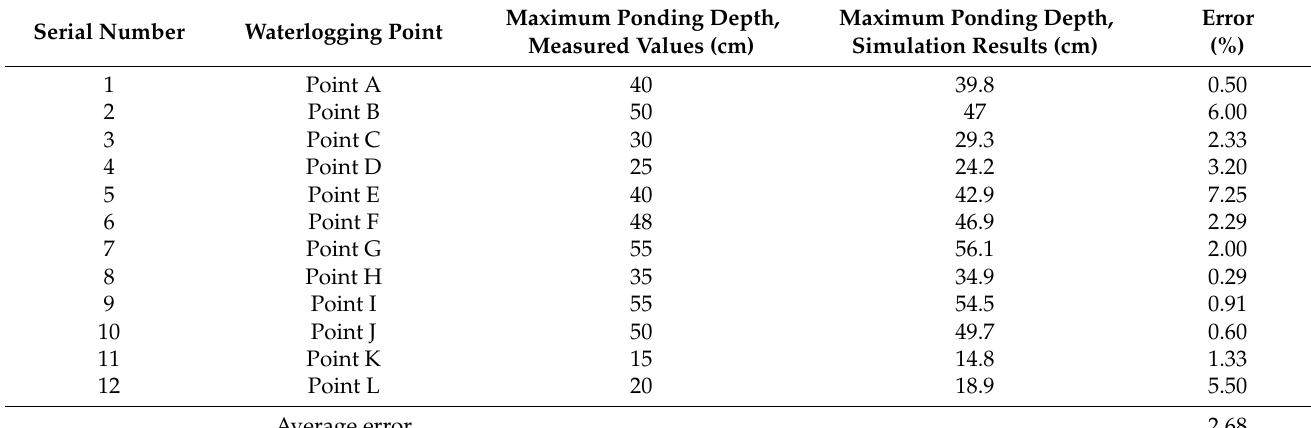
Table 1. Comparison of maximum ponding depths of measured values and simulated results at waterlogging points during a heavy rainstorm in Shenzhen on 29 August 2018 .